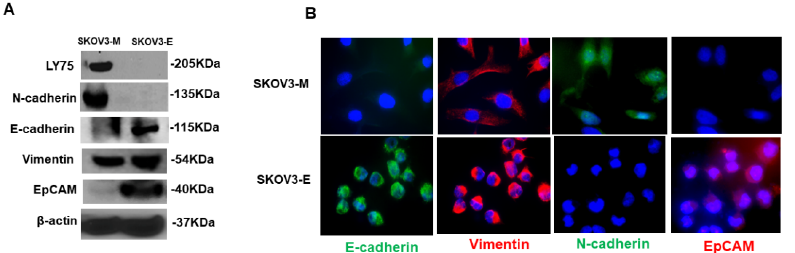
Figure 3. Protein expression analysis of different EMT markers in SKOV3-M and SKOV3-E cells. ( A ) Western blot analysis of the protein expression of LY75, N-cadherin, E-cadherin, vimentin and EpCAM in SKOV3-M and SKOV3-E cells. β -actin was used as a loading control. ( B ) Immunofluorescence analysis of the protein expression of N-cadherin, E-cadherin, vimentin and EpCAM in SKOV3-M and SKOV3-E cells (magnification at 60×).